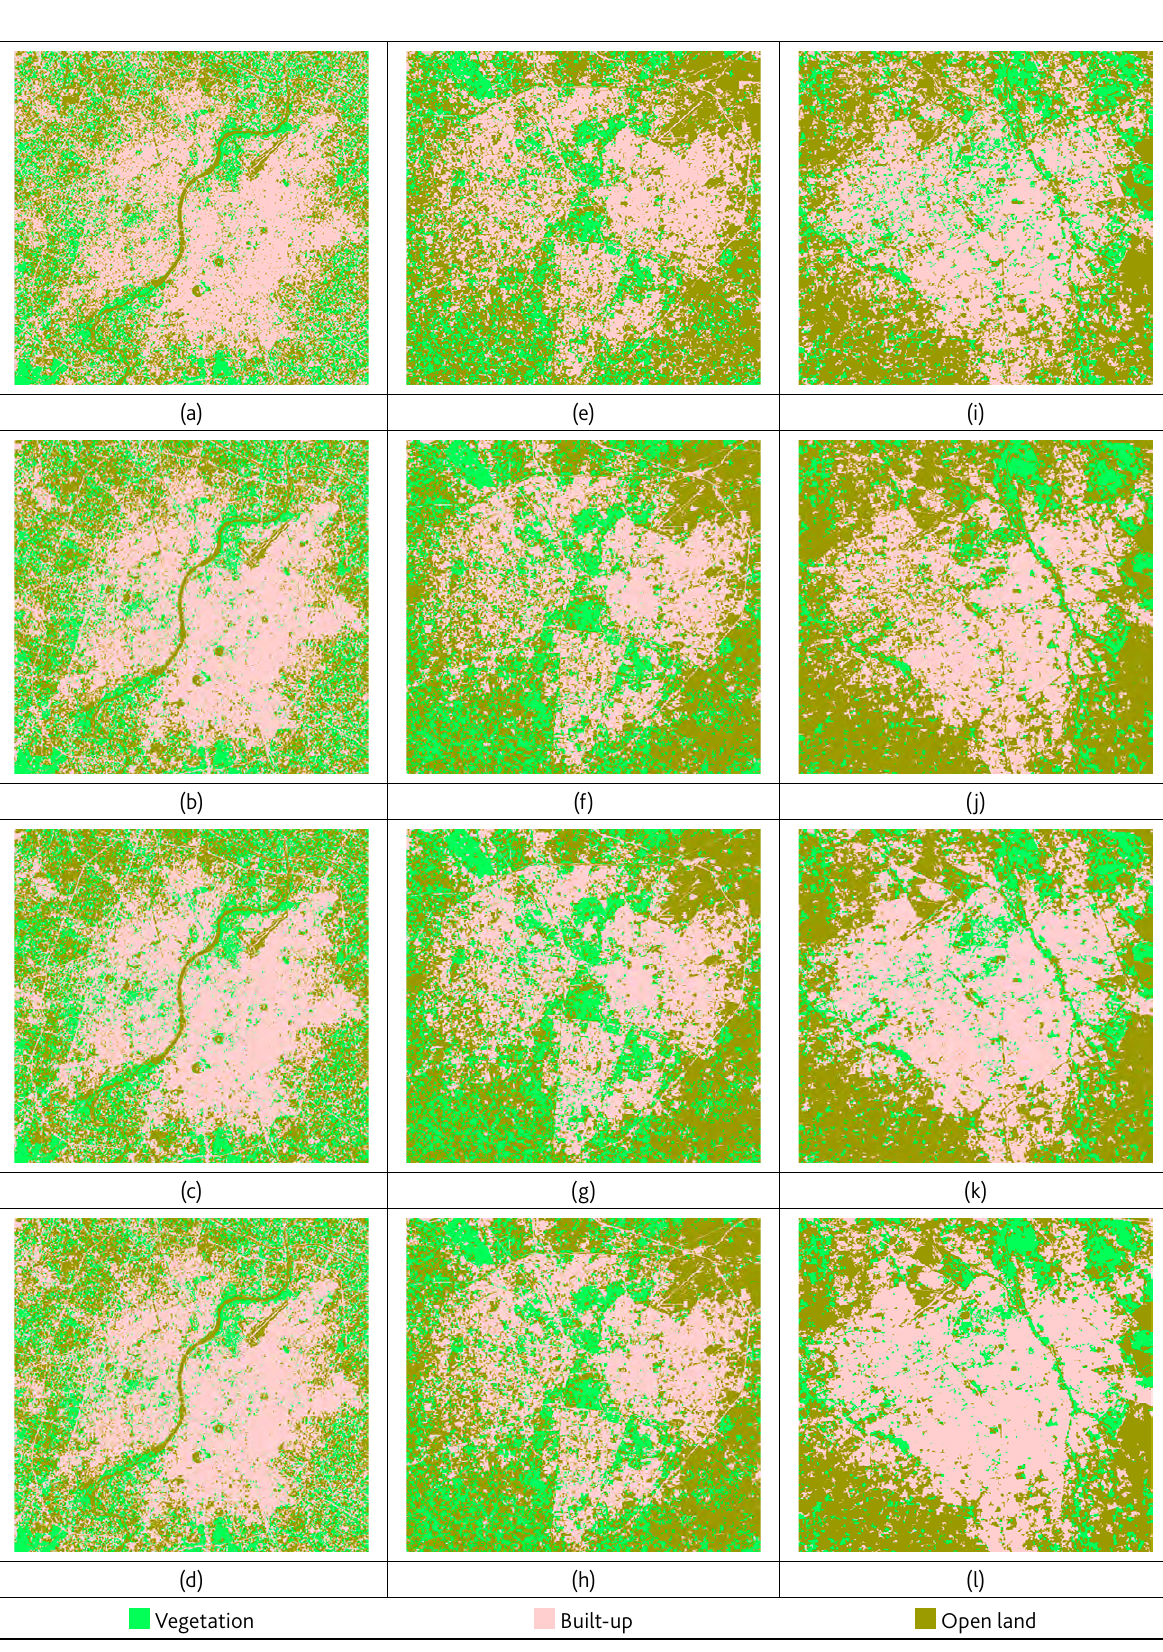
Figure 3. classified images of (a) DT, (b) RF, (c) ETC and (d) ABRFC classifiers for Ahmedabad 2020 data set; (e) DT, (f) RF, (g) ETC and (h) ABRFC classifiers for Vadodara 2020 data set and (i) DT, (j) RF, (k) ETC and (l) ABRFC classifiers for Rajkot 2021 data